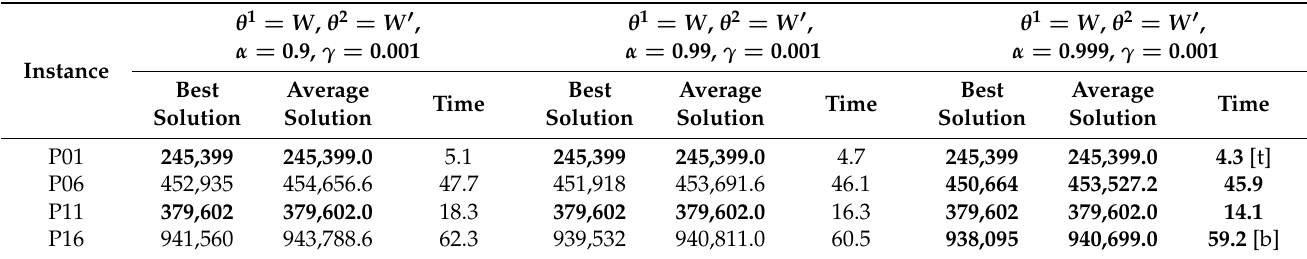
Table 4. The result of instances by HCDBAVNS with different α